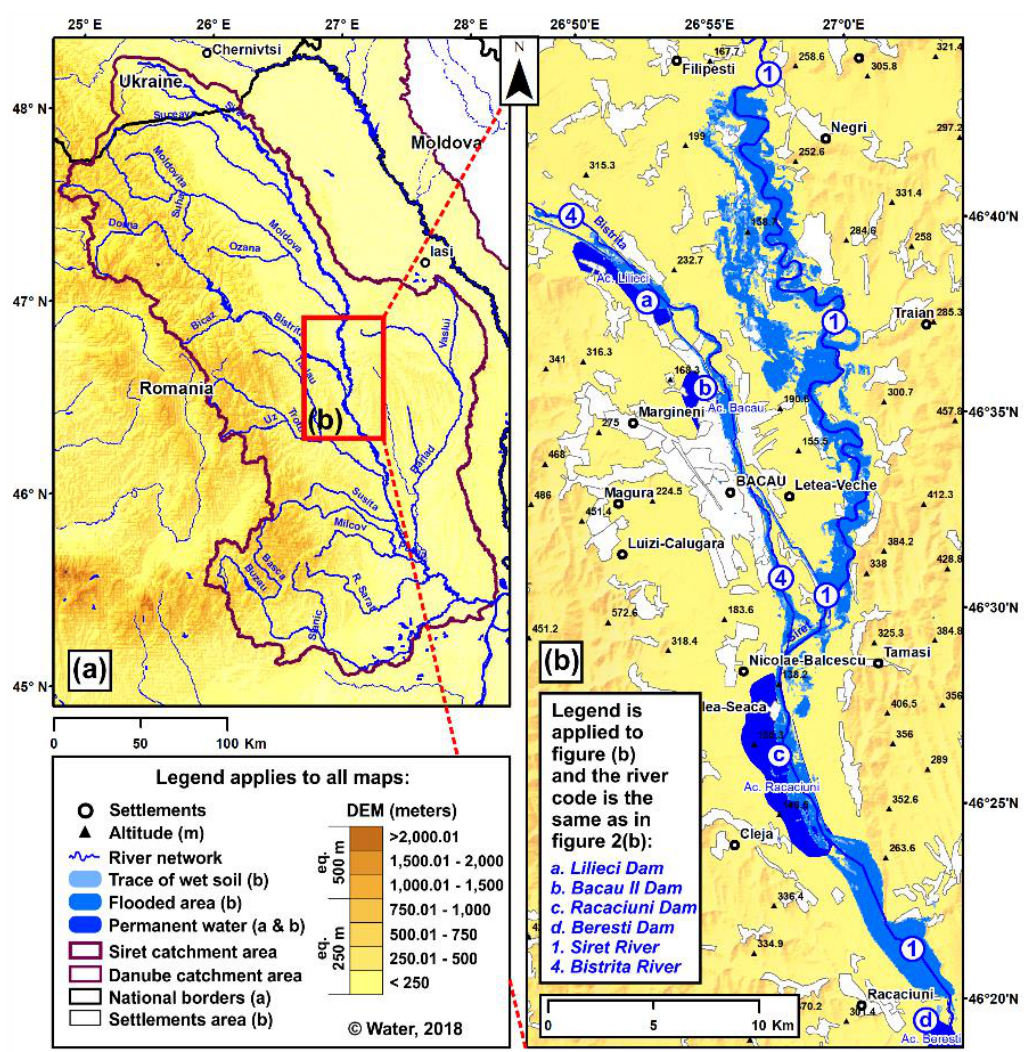
Figure 4. ( a ) Geographic location of the flood events (26 June to 5 July 2010) within the Siret catchment area; ( b ) historical flood on the Siret River extracted from LANDSAT TM and LANDSAT ETM+ scenes from 3 July 2010.